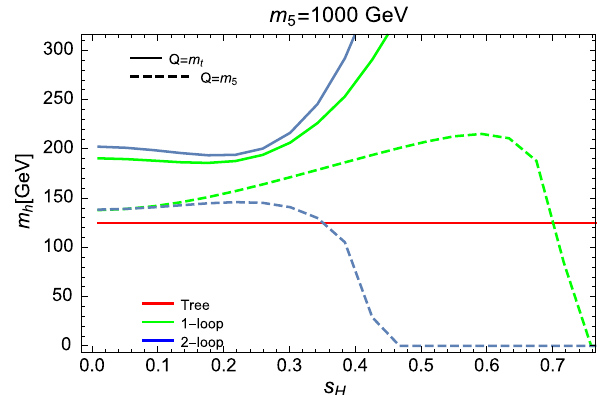
Fig. 10 The SM-like Higgs mass at tree-, one- and two-loop level for m 5 = 1 TeV and as a function for s H . The results for two different choices for the renormalisation Q scale are